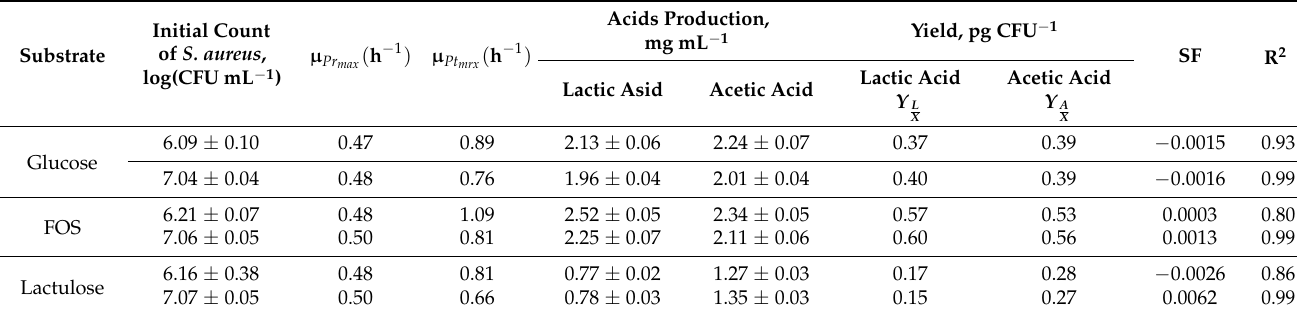
Table 2. Growth characteristics and parameters of the minimum inhibitory concentration (MIC) model calculated for mixed cultures of S. aureus and B. bifidum on glucose, fructooligosaccharides (FOS), or lactulose while varying the initial Staphylococcus population.